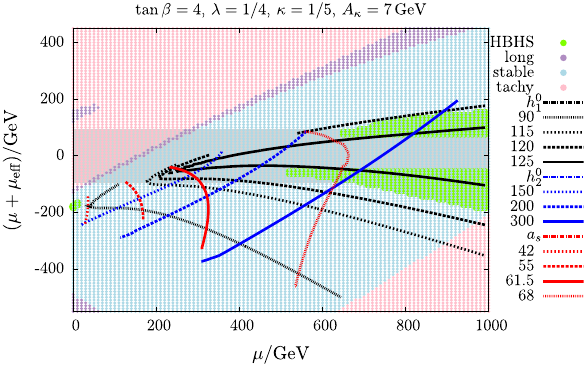
Fig. 8 The behavior of the masses of the three lightest neutral Higgs states in a scenario with λ = 1 / 4, κ = 1 / 5, tan β = 4 and A κ = 7GeV is shown. In contrast to Figs.4, 5, 6, 7, the black and blue lines show the mass contours of the lightest and second lightest CP -even Higgs mass eigenstate, respectively. The remaining parameters are chosen accord- ing to Table